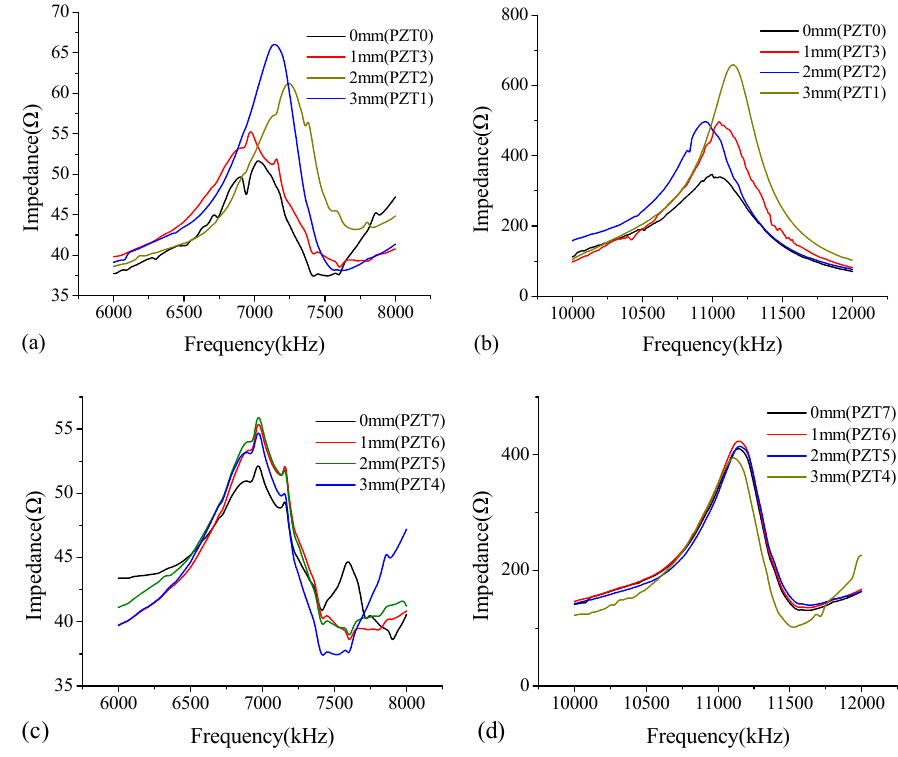
Figure 5. Impedance curves of PZT sensors bonded on the steel plate surface of the B-type specimen under the excitation frequency bands of ( a ) 6000–8000 kHz; ( b ) 10,000–12,000 kHz; Impedance curve of PZT sensors bonded on the UHPC surface of the B-type specimen under the excitation frequency bands of ( c ) 6000–8000 kHz; and ( d ) 10,000–12,000 kHz.